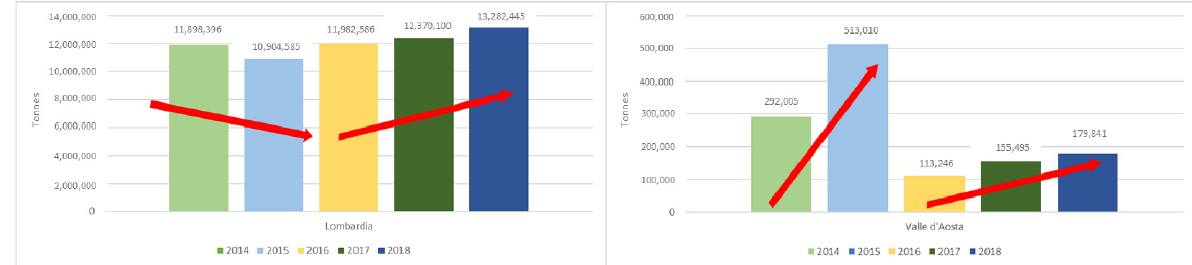
Figure 7. C&D waste production behaviour in the region of Lombardia and Valle D’Aosta. Source: Own elaboration with ISPRA data.